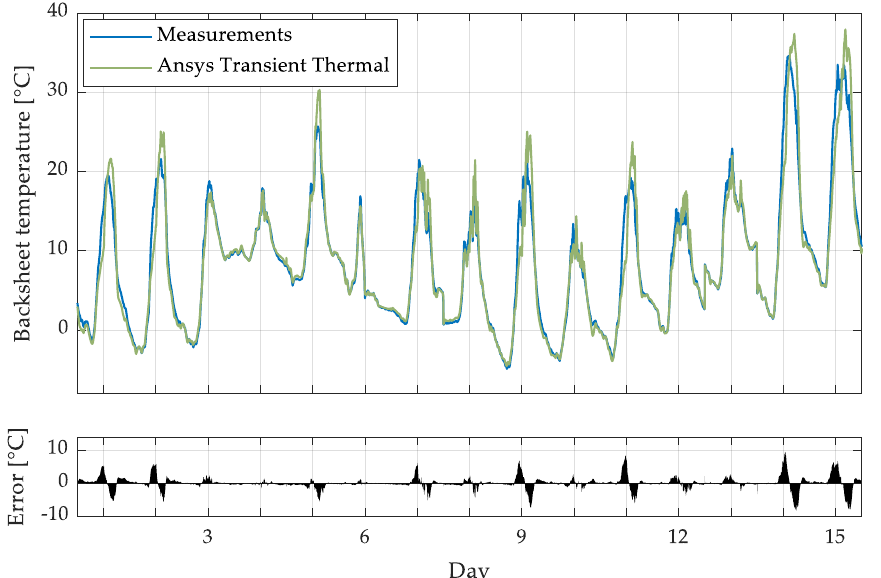
Figure 4. Validation of static thermal model (Ansys Transient Thermal) with measurements (for 15 days in March 2021).